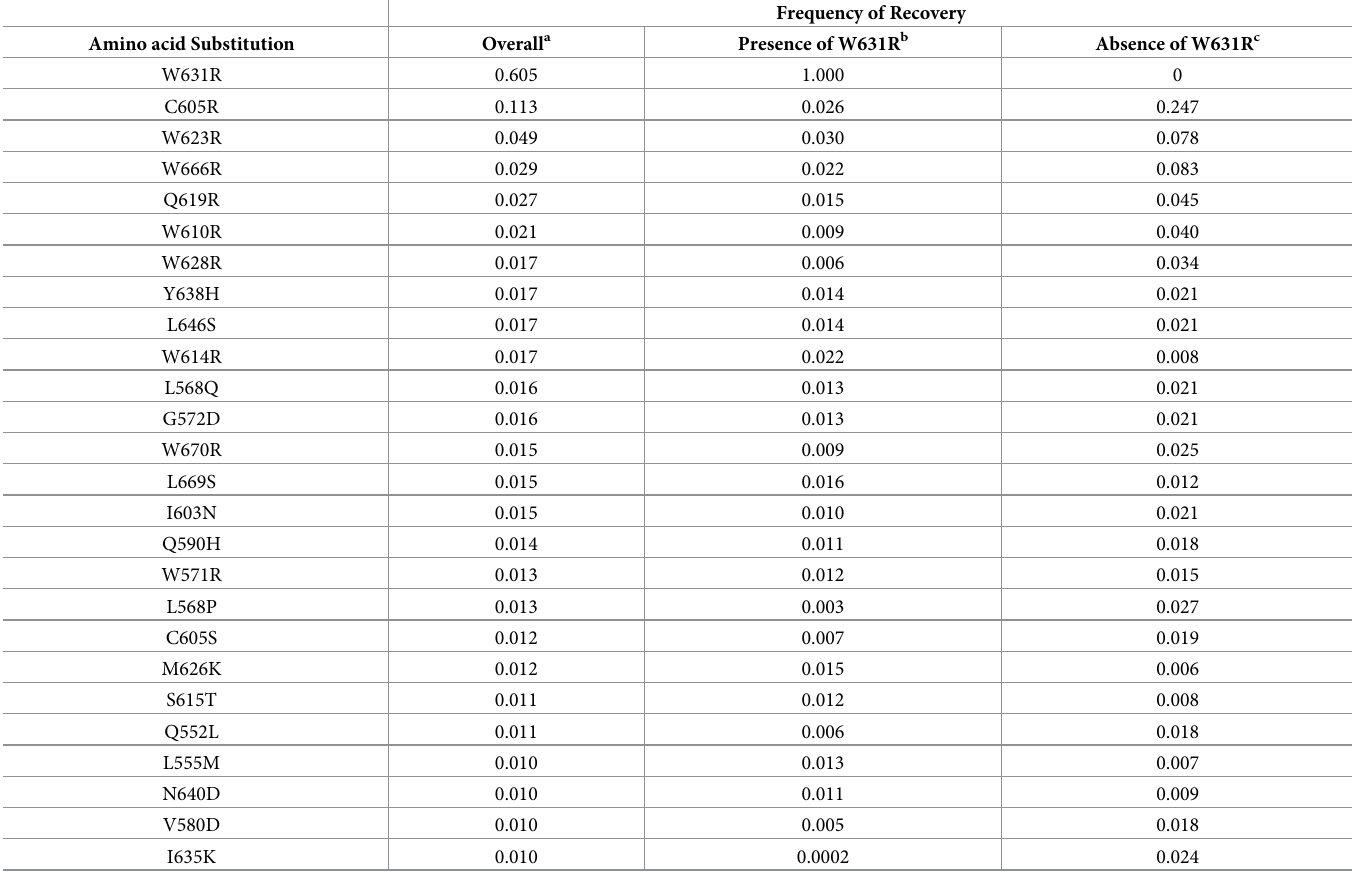
Table 2. Most abundant mutations recovered in NGS analysis of screen for binding to 4E10